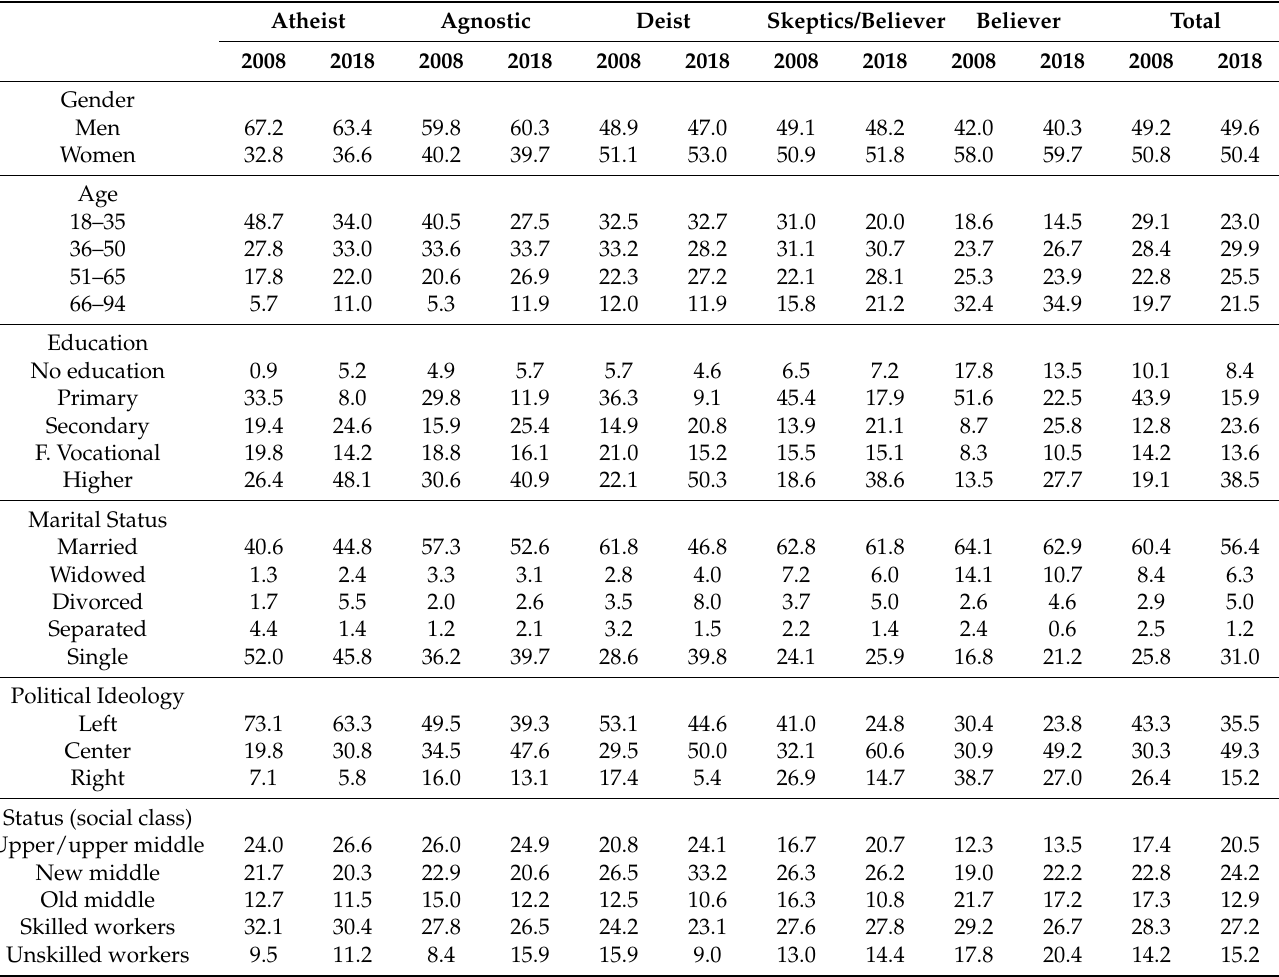
Table A2. Socio-demographic and socio-economic characteristics of Spaniards in 2008 and 2018 (column